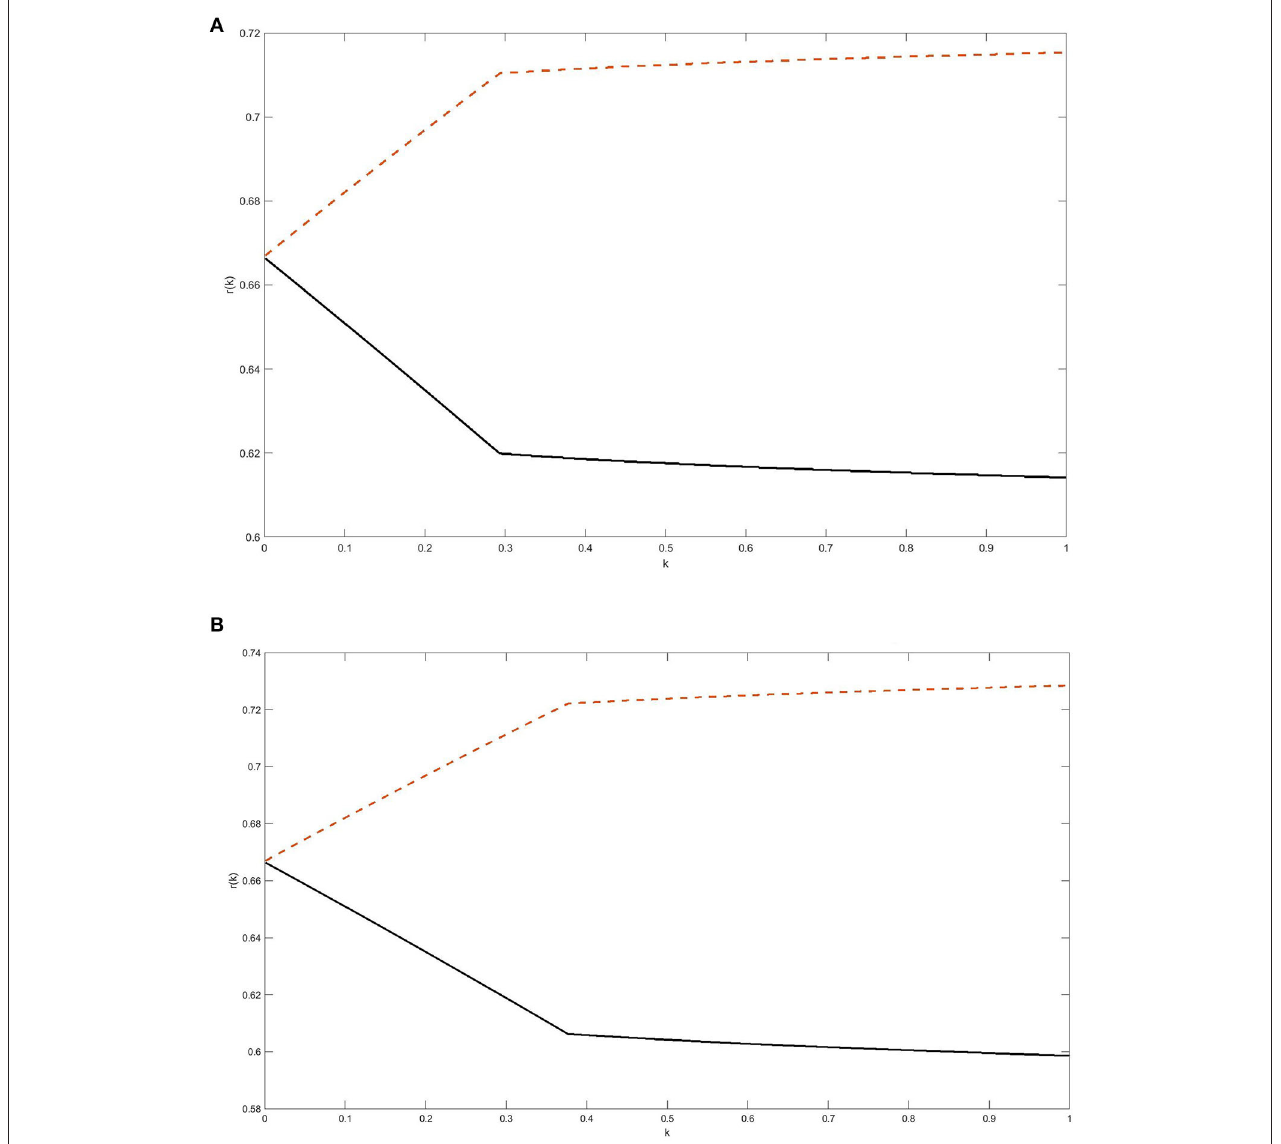
FIGURE 2 | (A,B) The weight of the faster growing subpopulation as a function of tumor shrinkage factor k: Gompertzian kinetics. The two surviving subpopulations of cancer cells were assumed to grow independently according to Gompertz laws with the same unspecified growth inhibition parameter β and carrying capacities K 1 10 13 cells and K 2 2.10 13 cells. The initial pre-treatment tumor size was assumed N 0 10 9 cells in A and 10 10 cells in B . The weight r(k) of the faster growing = = = subpopulation was computed at the time when re-growing residual tumor reaches a lethal size M 10 12 cells. For the initial post-treatment weight, p, of the faster = growing subpopulation we adopted the values of p 0.5 or p 0.8; the respective plots for r(k) are the lower (solid) curve and the upper (dashed) curve in (A,B) . For = = background and relevant equations, see section Expansion of Interacting Clones: Gompertzian